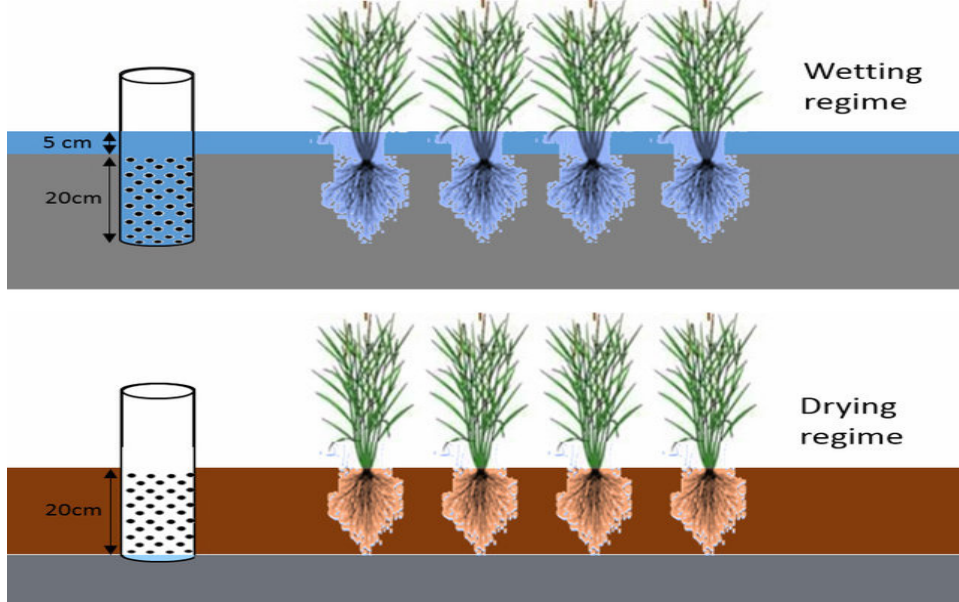
Figure 1. Alternate wetting and drying (AWD) irrigation of rice (Image collected from Riaz et al. [12]).